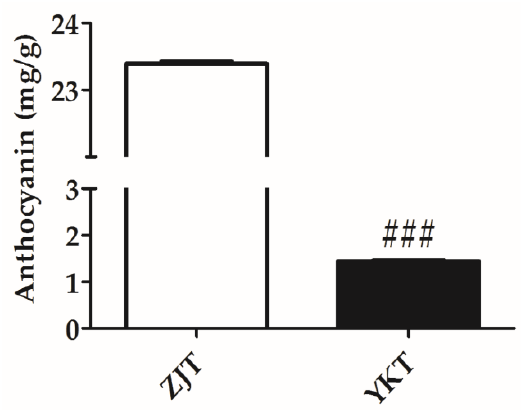
Figure 3. Concentration of anthocyanin in ZJT and YKT (mg/g) ( n = 3, mean ± standard error of the mean (SEM)), ### p < 0.001, compared to mean (SEM)), ### p < 0.001, compared to ZJT.